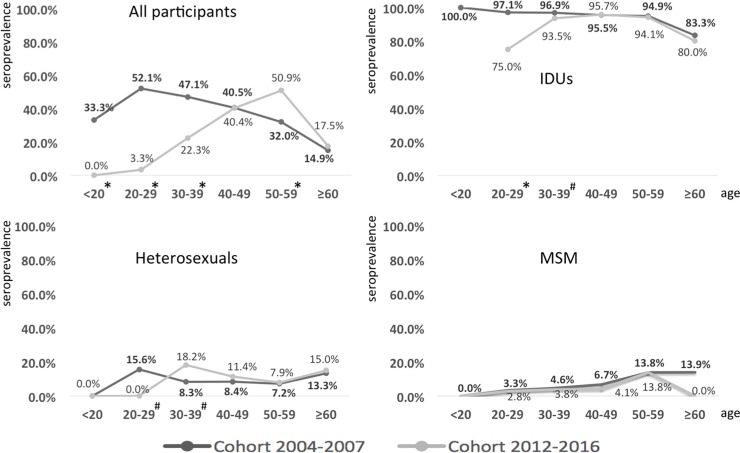
Seroprevalence of hepatitis C virus (HCV) infection among human immunodeficiency virus (HIV)-positive patients of different transmission routes and age groups in the 2004–2007 cohort and 2012–2016 cohort.IDUs: injecting drug users; MSM: men who have sex with men. *P<0.001; #P<0.05.